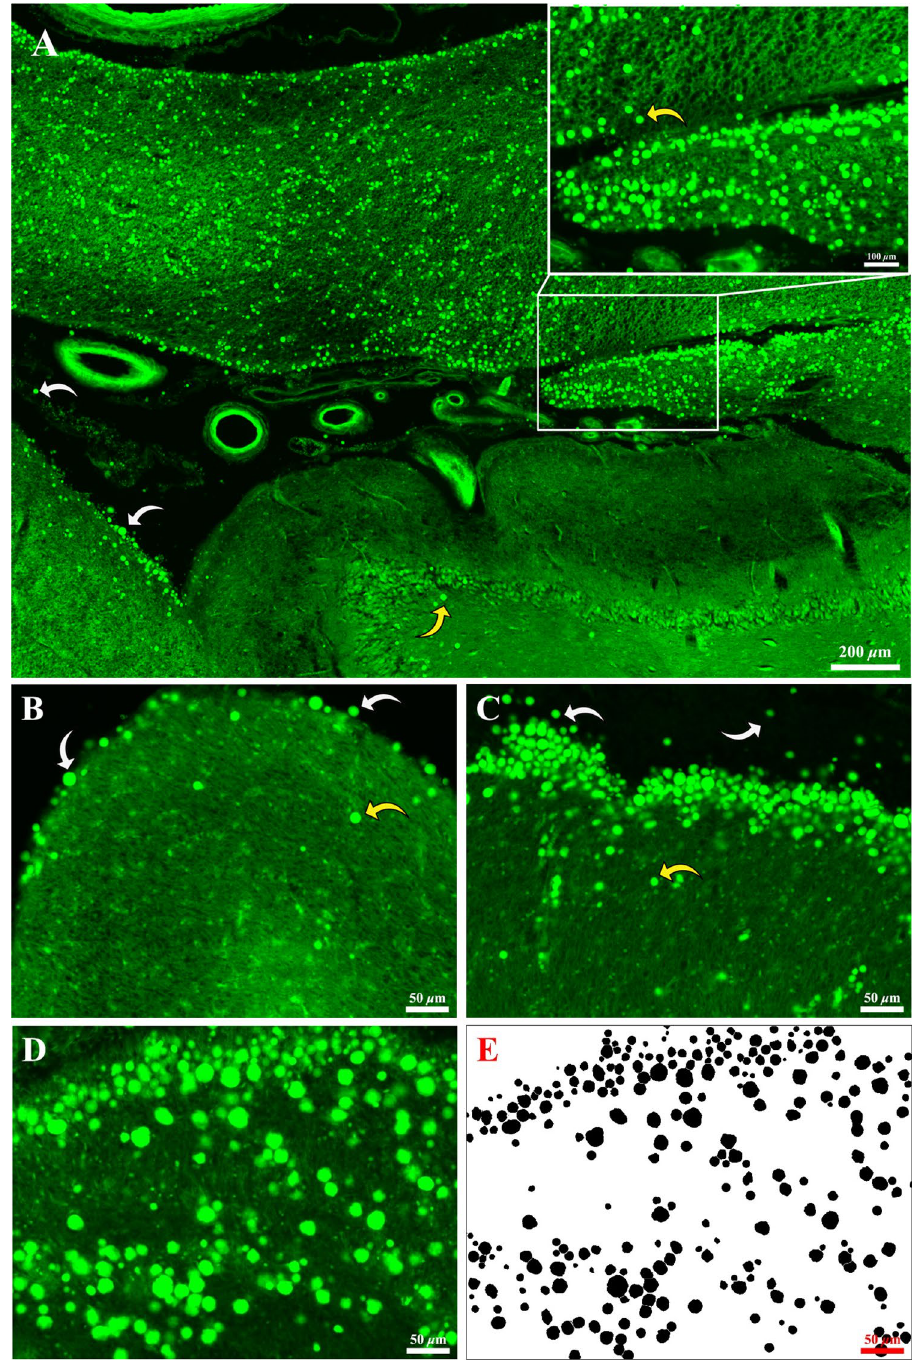
Figure 1. ( A ) Representative low-mag CoA distribution micrograph under fluorescent mode (FITC) in the fimbria region. Inset was captured with the ‘Crop’ tool in Olympus CellSens software at a resolution of 8000 × 6000 pixels. Individual CoA are indicated by arrows. Higher magnification micrographs (1600 × 1200 pixels) ( B , C ) show aggregations of CoA beneath the pial surface (yellow arrows), while some CoA are observed within the cavity of the ventricle or straddling the pial surface (white arrows). Representative demonstration of original micrograph ( D ) and the corresponding rendered image ( E ) in the fimbria region generated with Photoshop software for data collection and analysis (1600 × 1200 pixels). Note the demonstrated micrograph was the 3rd plane of a 5-step Z-stack (Z range 20 µm, step size 4 µm), the upper and lower step images were referred to in order to generate the processed image. Therefore, in some cases minor mismatching occurs between the processed image and the single slice immunofluorescent